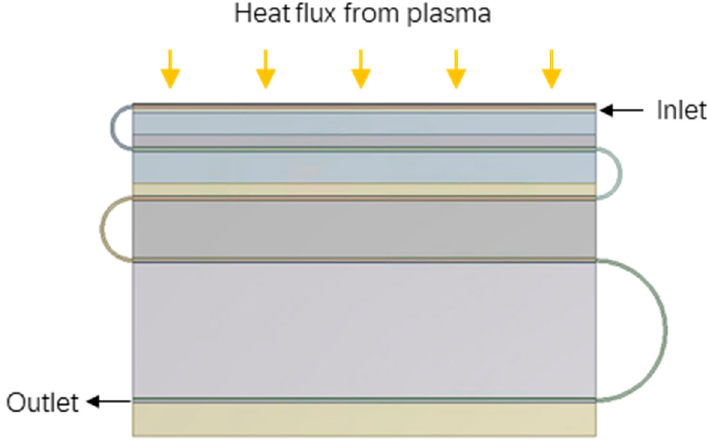
Figure 14. The 2D WCCB thermal-hydraulics model.